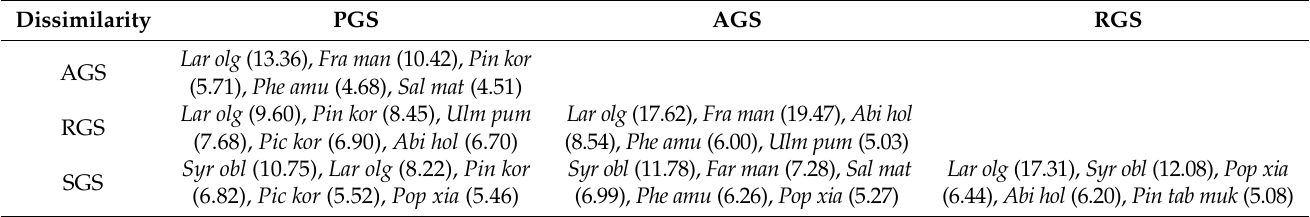
Figure 6. Dissimilarity among four types of green spaces based on species richness of middle-aged trees found by SIMPER analysis. RGS, road green spaces; SGS, square green spaces; AGS, attached green spaces; PGS, park green spaces. Table 4. Main contributing species of middle-aged trees to the dissimilarity of different types of green spaces. RGS, road green spaces; SGS, square green spaces; AGS, attached green spaces; PGS, park green spaces. Values in parentheses represent the contribution of each species to the dissimilarity. For abbreviations of species names, refer to Table A1.